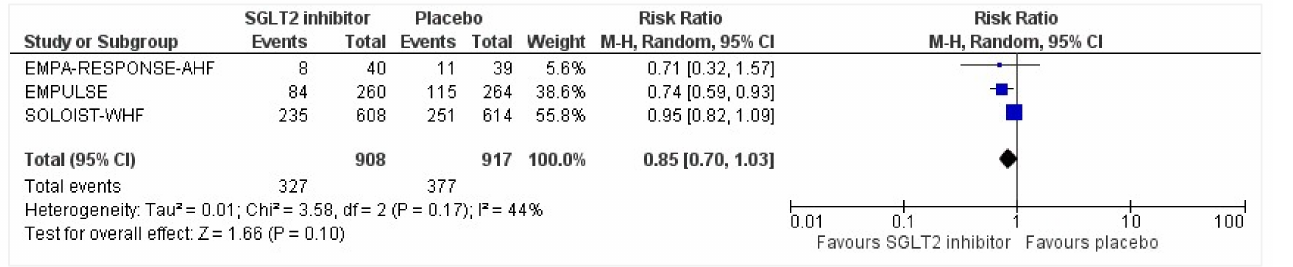
Figure 7. Forest plot of the total number of patients who had at least one serious adverse event in either group